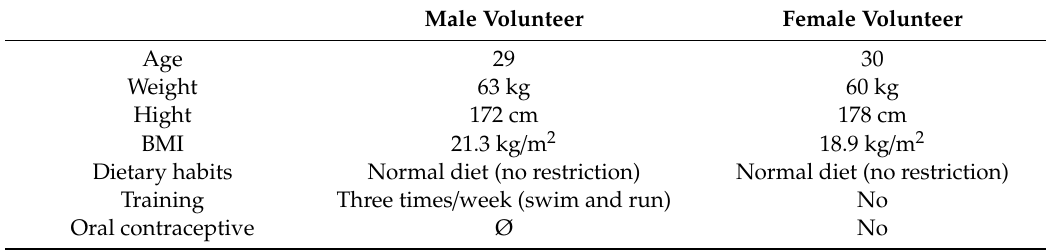
Table 1. Additional information on male and female volunteer included in this